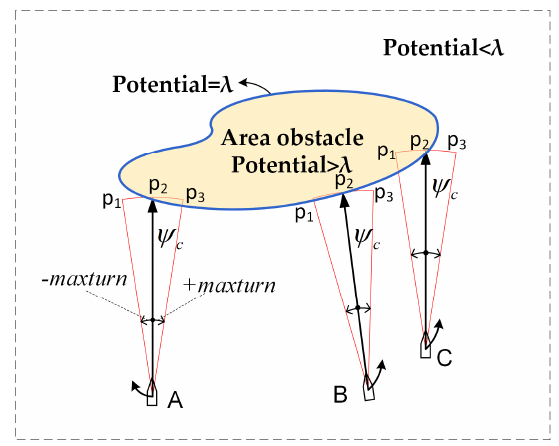
Figure 9. Course alteration determined by the minimum potential following method.